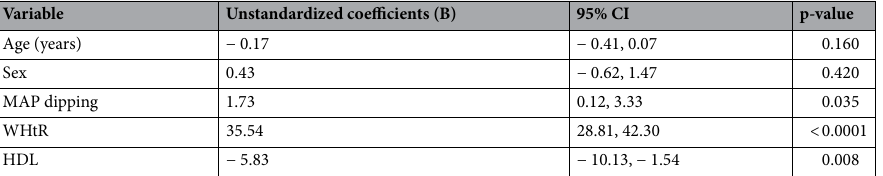
Table 4. Multivariable regression analysis of TMI adjusted for age, sex, MAP dipping, HDL and WHtR. MAP mean arterial pressure, HDL high-density-lipoprotein, WHtR waist-to-height